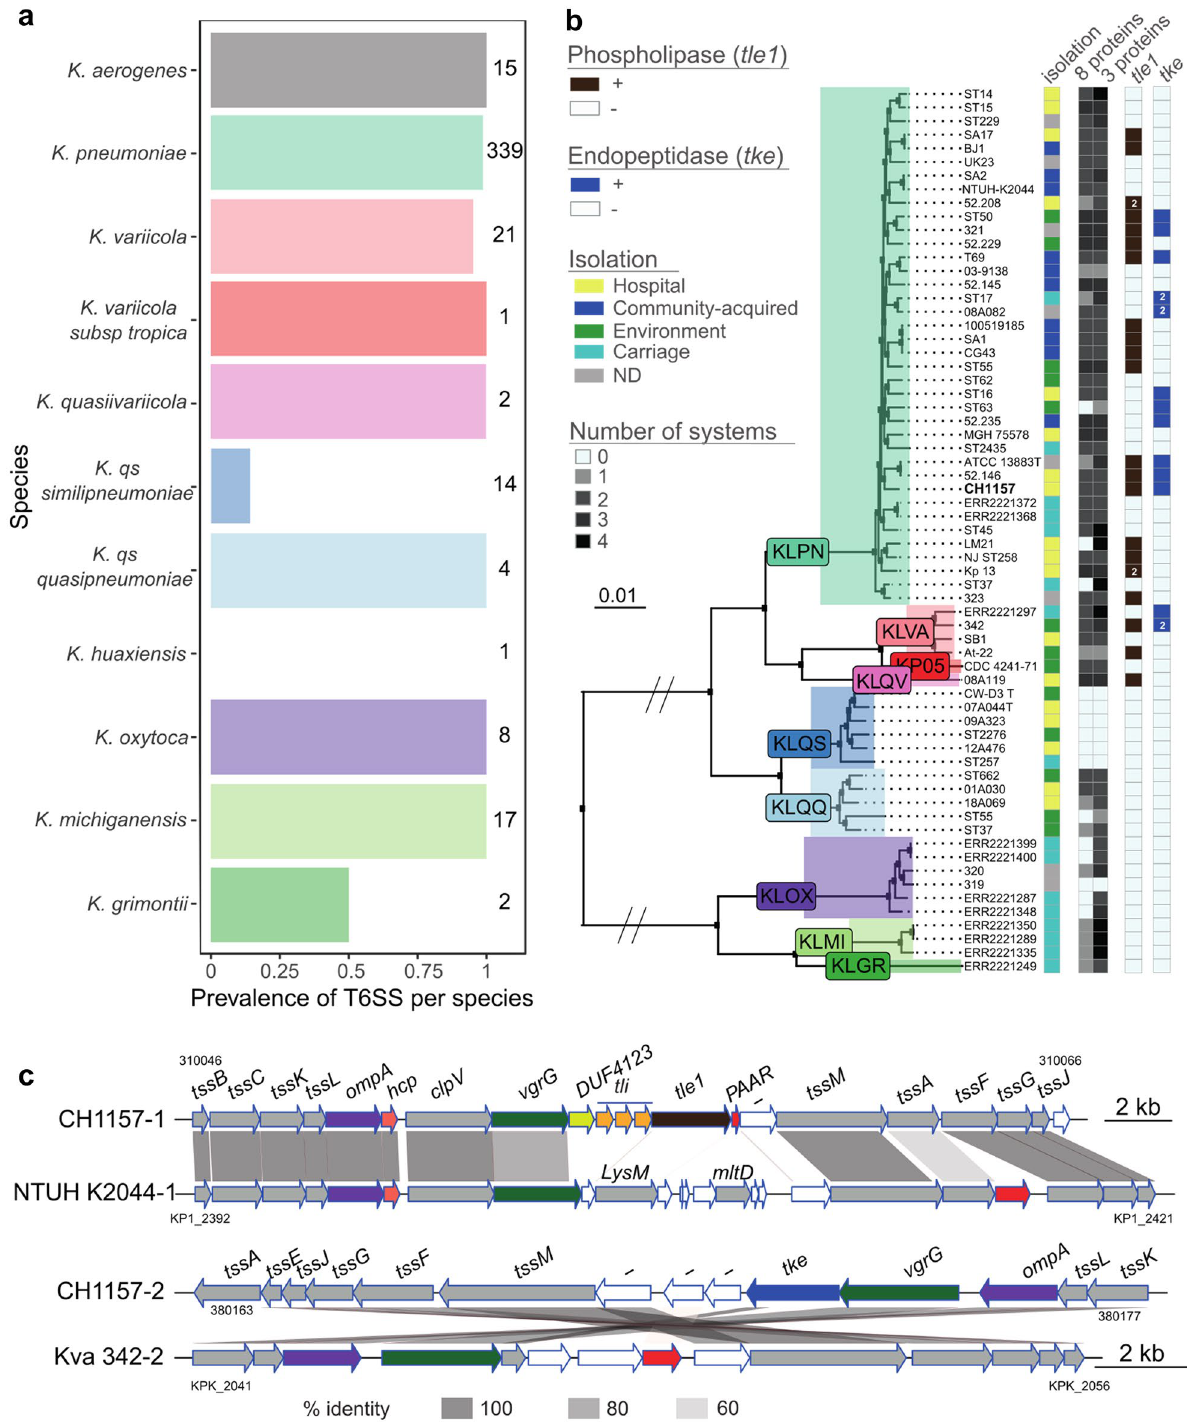
Figure 1. Distribution and characterization of Type VI secretion systems across the Klebsiella genus. (a) Prevalence of T6SS is calculated as the ratio of genomes of each species with at least one complete T6SS. Numbers represent the total number of genomes analyzed per species. ( b ) Unrooted tree built using 2969 families of the persistent genome of the representative strains of Klebsiella genus. The first column determines the environment from which the strains were isolated (ND not determined). The second and third columns report the number of T6SS per strain using a minimum number of 3 or 8 proteins, respectively, to consider the presence of a T6SS cluster. The last two columns indicate the presence or absence of phospholipase-encoding and endopeptidase-encoding genes (with at least 80% and 50% identity to that found in T6SSs clusters, respectively). The tree was built using the packages ggtree and treeio for R. KLPN : K. pneumoniae ; KLVA : K. variicola ; KP05 : K. pneumoniae 05 ; KLQV : K. quasiivariicola ; KLQS : K. qs similipneumoniae ; KLQQ : K. qs quasipneumoniae ; KLOX : K. oxytoca ; KLMI : K. michiganensis ; KLGR : K. grimontii (c) Diagram of the two clusters of CH1157 strain, one of strain NTUH-K2044 and another of K. variicola 342. White arrows indicate unknown function, and gray arrows indicate genes that are core to the T6SS. The diagram was built with the genoplotR package 64 . The identity percentages were calculated using blastp (v BLAST 2.7.1+, default